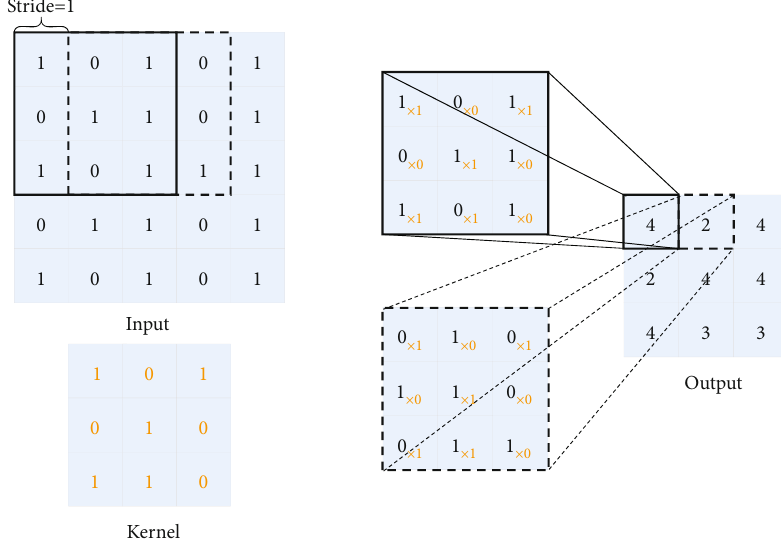
Figure 3: Illustration of the convolution process with bias of zero.